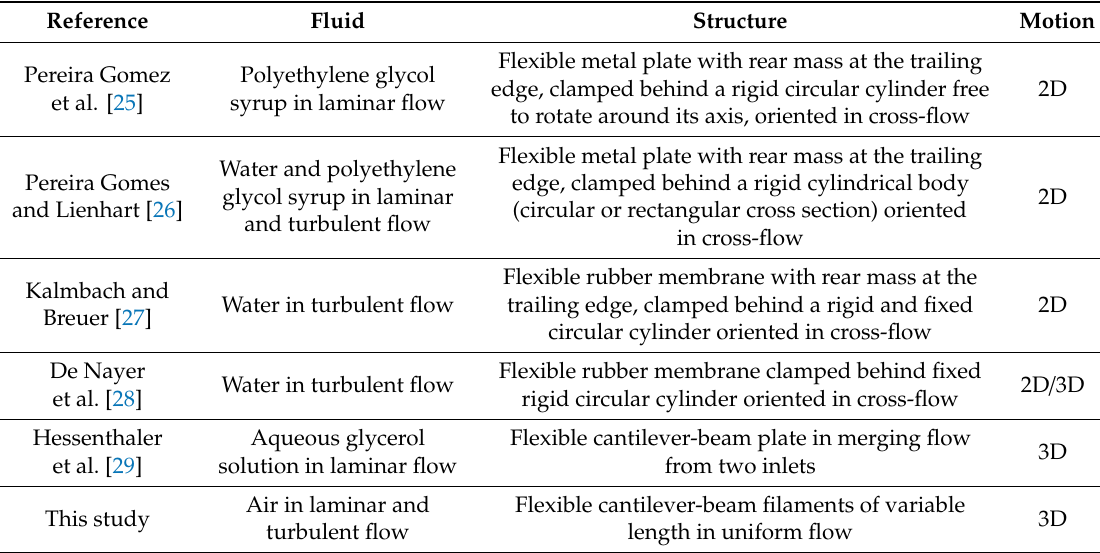
Table 1. Experimental FSI validation test